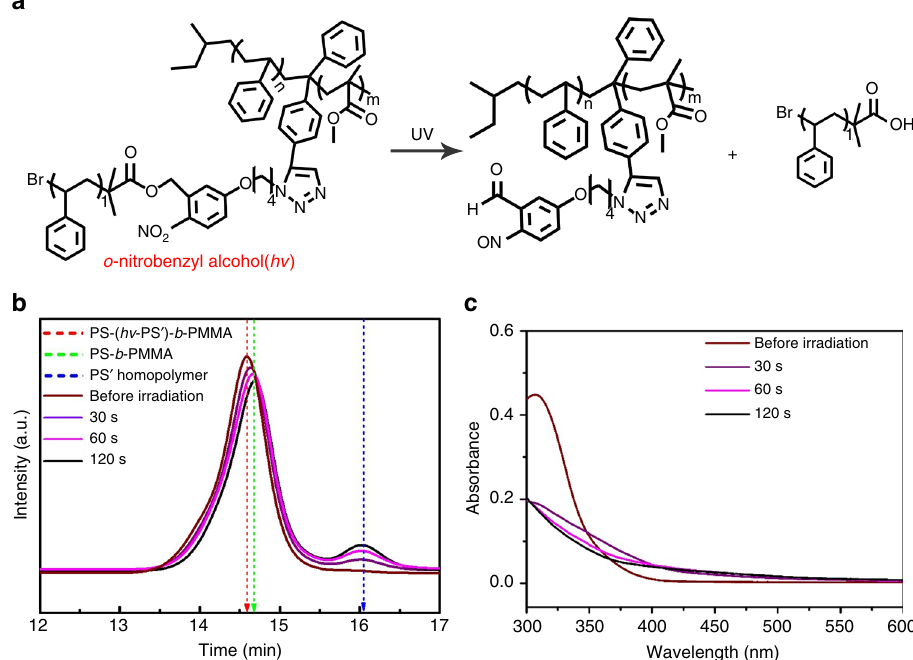
Fig. 1 Photocleavage of PS( hv -PS ′ )- b -PMMA during UV irradiation at 365 nm. a Chemical structure change during photocleavage from PS( hv -PS ′ )- b - PMMA to a binary blend of PS- b -PMMA and PS ′ homopolymer. Changes of b SEC trace and c UV absorbance of PS( hv -PS ′ )- b -PMMA during UV irradiation up to 120